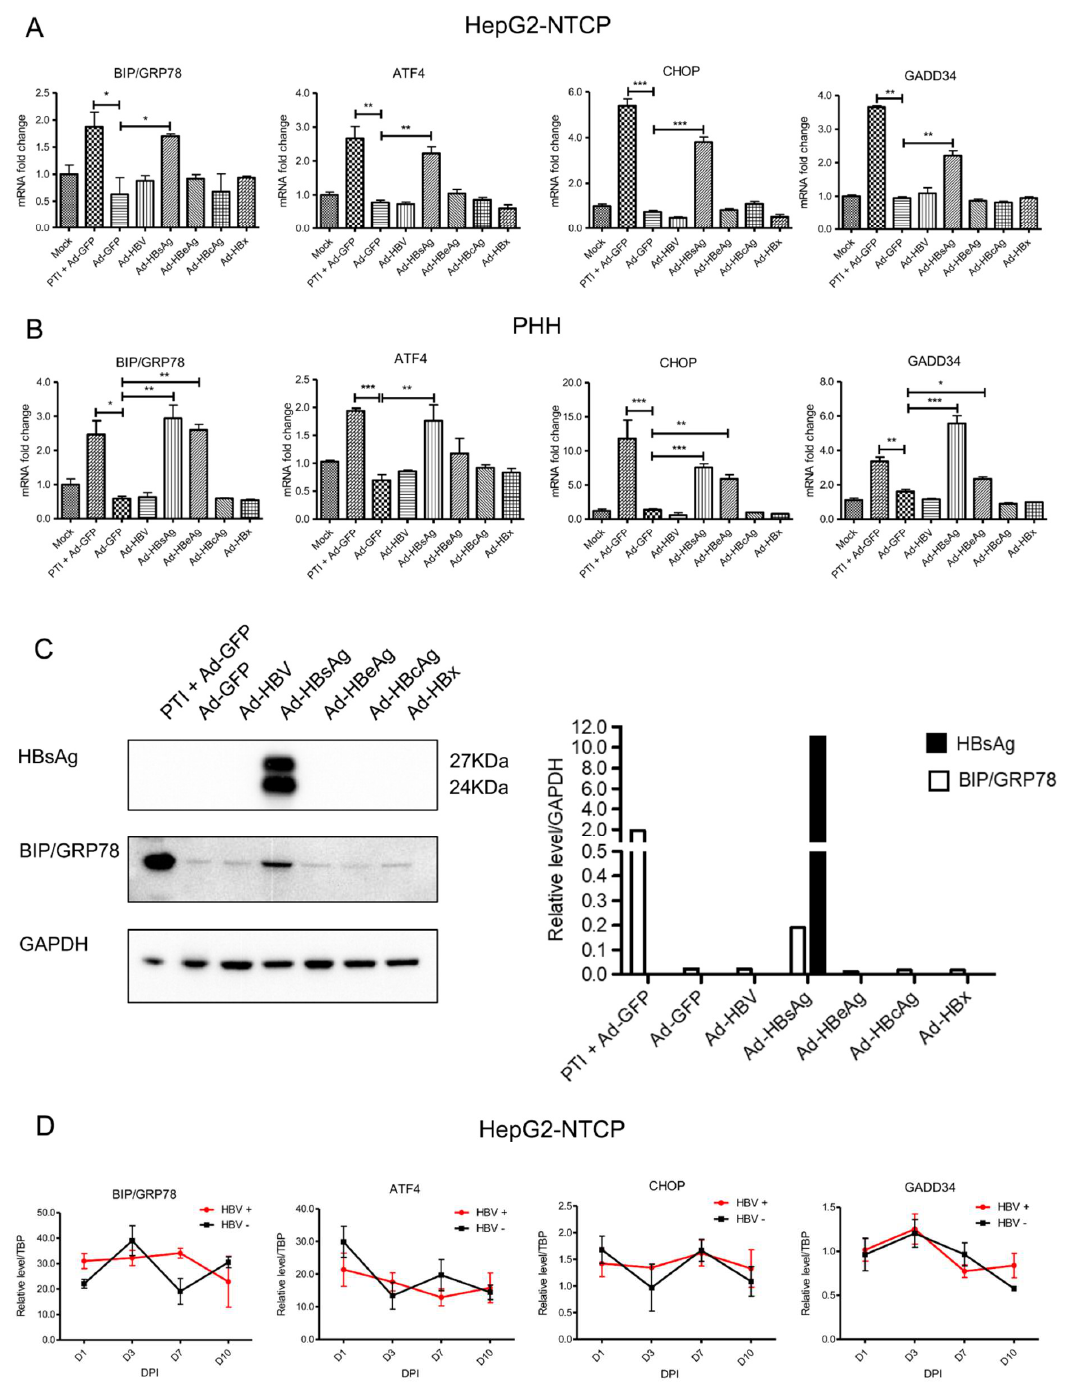
Figure 1. Activation of PERK pathway genes by HBsAg overexpression. ( A ) HepG2-NTCP cells and ( B ) primary human hepatocyte cells were transduced with recombinant AdVs in triplicate (MOI of 1). Protein transportation inhibitor (PTI) was used as a positive control. mRNAs of PERK genes were determined by RT-qPCR three days after AdVs transduction. Relative mRNA expression was normalized to housekeeping gene TBP and mock control. The Student’s unpaired two-tailed t test was applied for data analysis. * p < 0.05, ** p < 0.01, *** p < 0.001. ( C ) Expression of HBsAg and BIP / GRP78 were determined by Western blotting in AdVs-transduced HepG2-NTCP cells. ( D ) HepG2-NTCP cells were infected with infectious HBV (MOI of 300). UPR markers were analyzed at di ff erent days post infection (DPI). Relative level to reference TATA-binding protein (TBP) was calculated. All results were confirmed by three independent